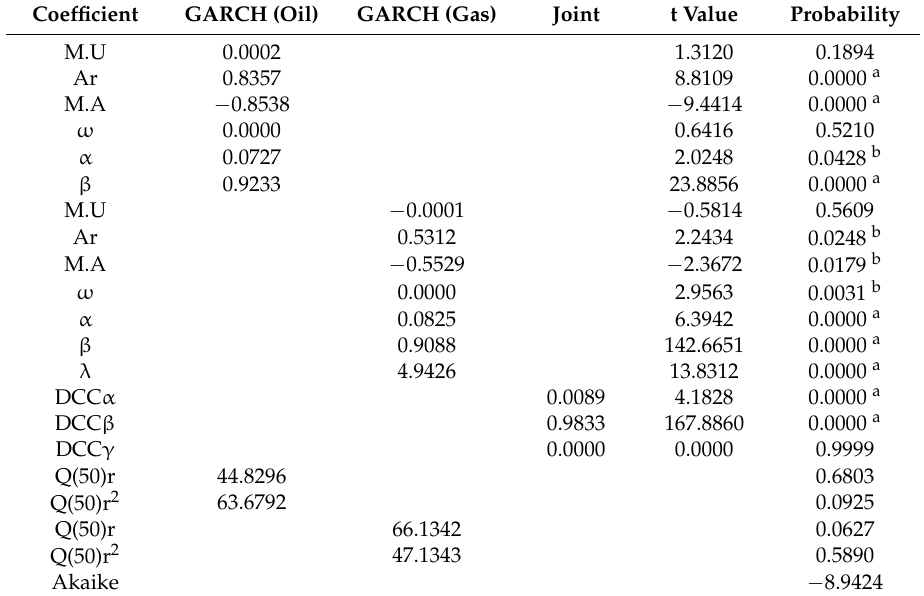
Table 7. Asymmetrical DCC GARCH